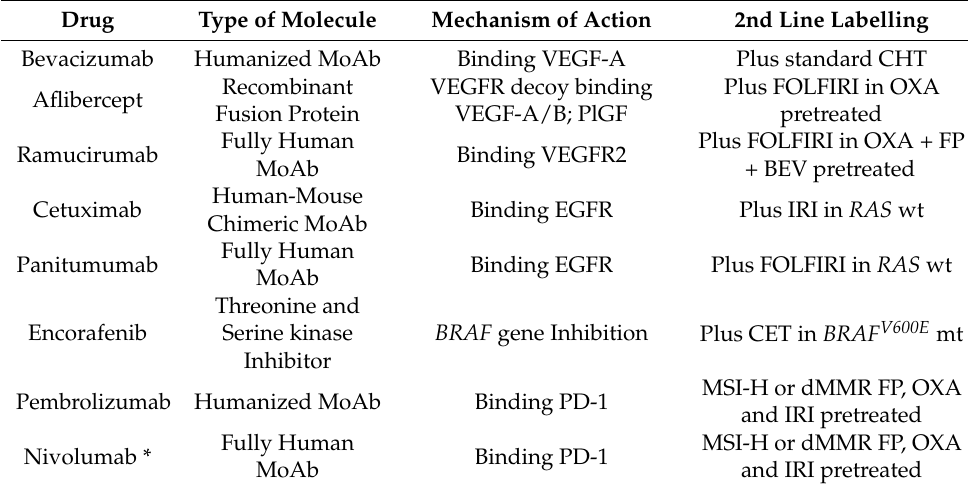
Table 1. Target agents approved in mCRC second-line